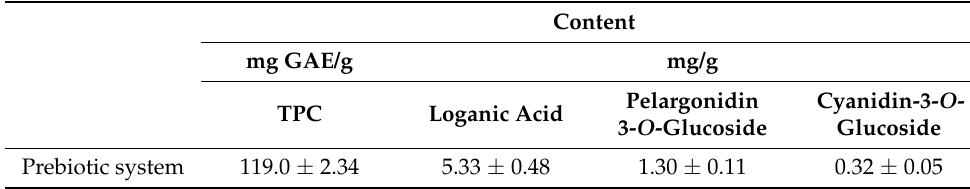
Table 3. The content of active compounds in the lyophilized Cornus mas system.